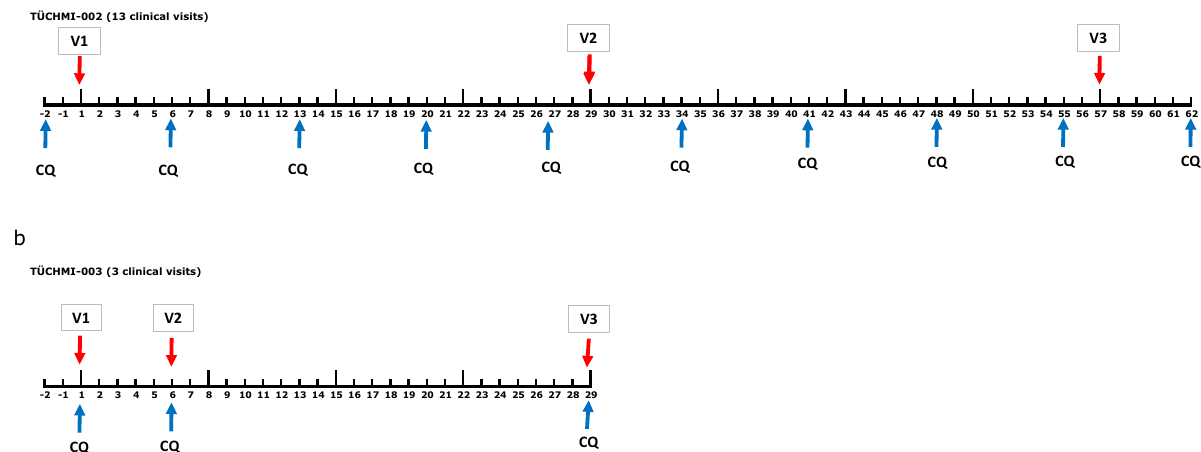
Fig. 1 Diagram illustrating the differences between the established and current vaccination regimen for PfSPZ-CVac (CQ). a The previously used vaccination regimen included 13 clinic visits during 9 weeks, 10 for administration of CQ, and 3 for immunizations 12 . b The immunization regimen assessed in this study included three clinic visits during 4 weeks, three for administration of CQ, and the same three for immunizations. Red arrows: vaccination time points; blue arrows: chloroquine treatment time